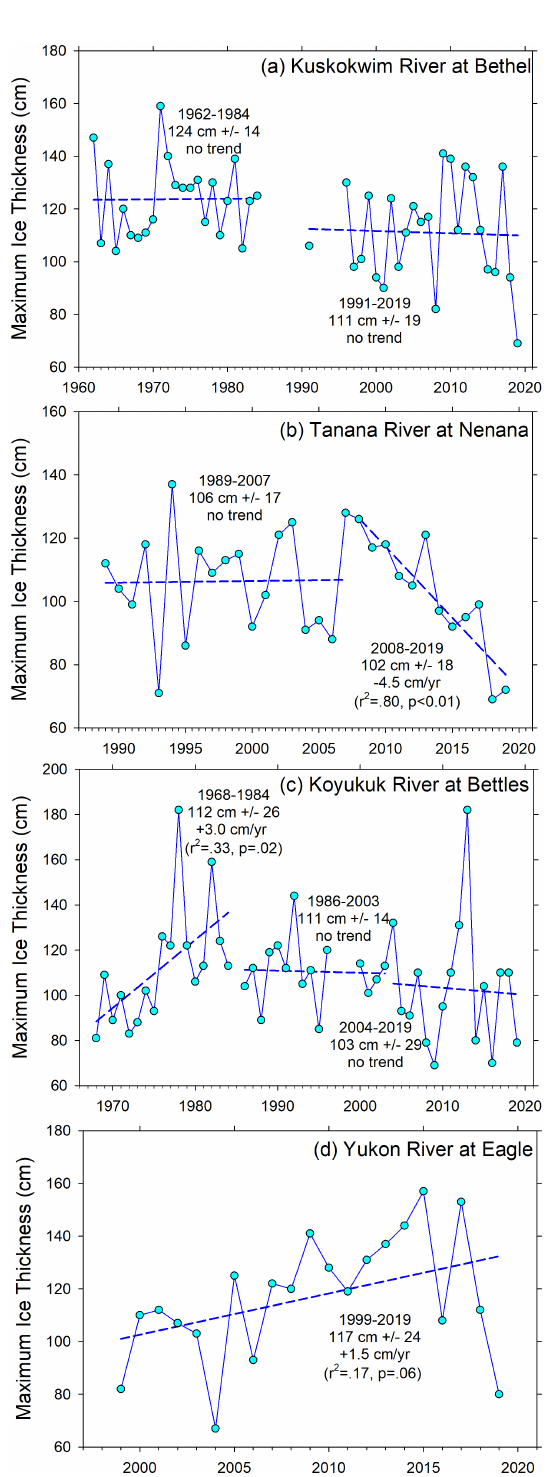
Figure 7. Maximum ice thickness patterns and trends for rivers near Bethel (a) , Nenana (b) , Bettles (c) , and Eagle (d) for each station’s period of